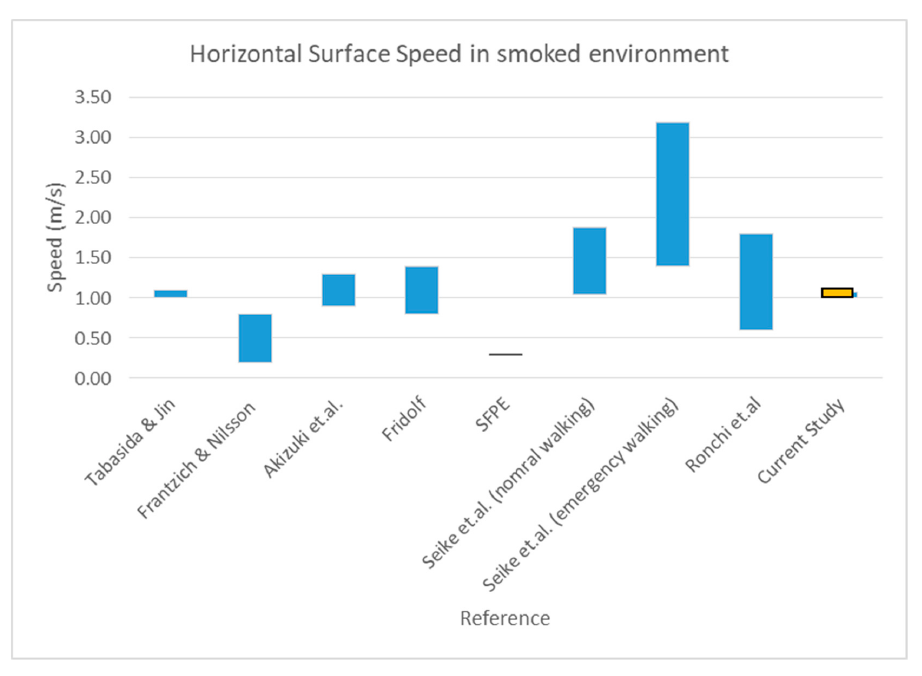
Table 5. Occupants’ speed (m/s) in drill no.2 (smoke-filled environment).